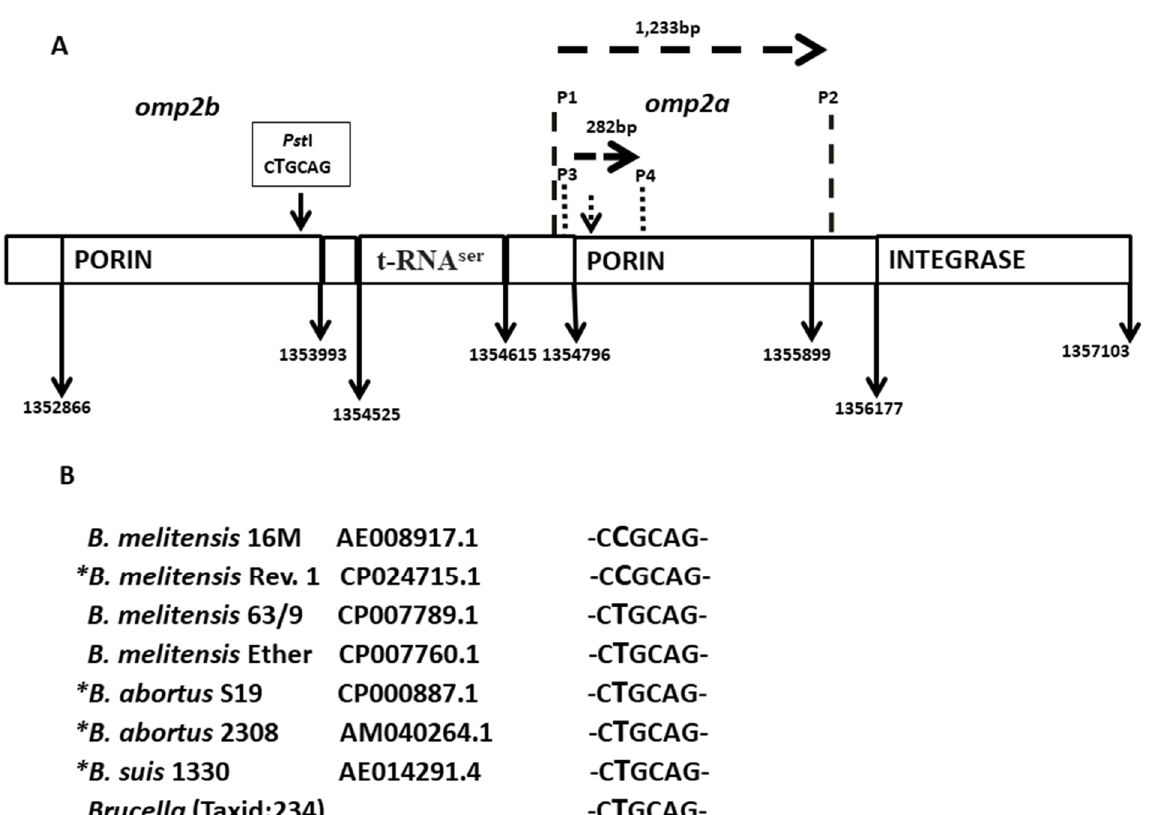
Figure 1. ( A ) Schematic presentation of the B. melitensis strain 16M omp2 region (arrows indicate locations in the chromosome of ORFs and primers). P stands for a primer. The size of the first amplicon (1233 bp) and nested PCR product (282 bp) as well as direction of gene transcription are indicated by broken arrows. Vertical broken short arrows stand for an apparent Pst I site. ( B ) The specific omp2a sequence which aligns with the corresponding Pst I site and accession numbers are given. Note that the Pst I site is lacking exclusively from strains 16M and Rev. 1. Star (*) stands for a reverse complementary sequence in comparison to that of B. melitensis 16M. SNPs are depicted by letters with an increased font size.